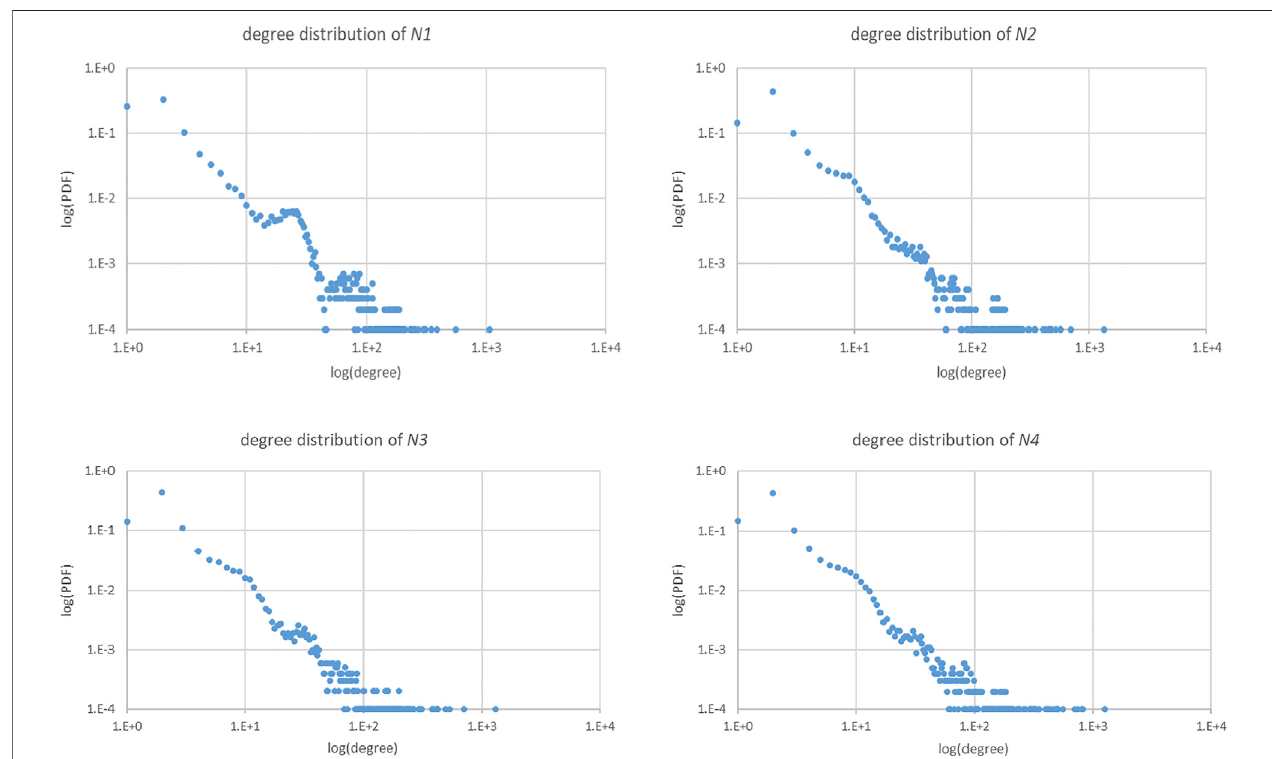
FIGURE 9 | Degree distribution of N1 ∼ N4.